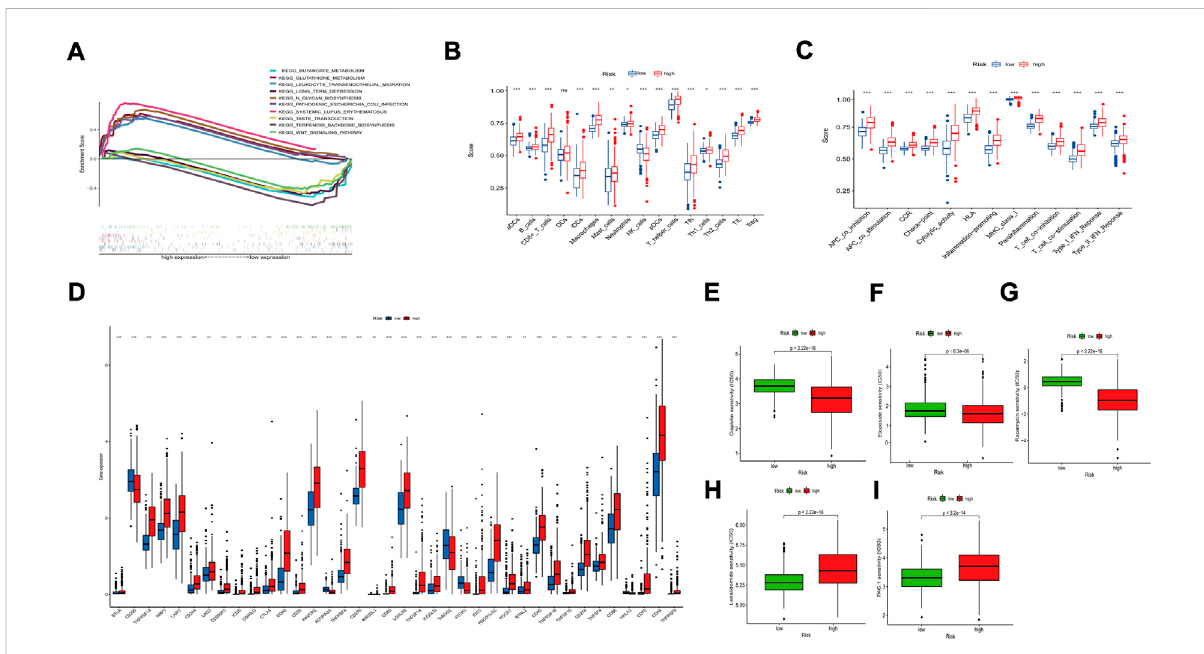
FIGURE 6 Functional enrichment analysis of 8 prognostic m 7 G-related lncRNAs. (A) KEGG analysis of 8 prognostic m 7 G-related lncRNAs. (B) The in fi ltration levels of 16 immune cells. (C) The correlation between the predictive signature and 13 immune-related functions. (D) Expression of immune checkpoints. aDCs, activated dendritic cells; iDCs, immature dendritic cells; NK, natural killer; pDCs, plasmacytoid dendritic cells; Tfh, T follicular helper; Th1, T helper type 1; Th2, T helper type 2; TIL, tumor-in fi ltrating lymphocyte; Treg, T regulatory cell; APC, antigen-presenting cell;CCR,chemokinereceptor;HLA,humanleukocyteantigen;MHC,majorhistocompatibilitycomplex;IFN,interferon.*p < 0.05;**p < 0.01;***p < 0.001; ns, non-signi fi cant. Comparison of treatment drugs sensitivity between high- and low-risk groups. (E – I) IC50 of Cisplatin,